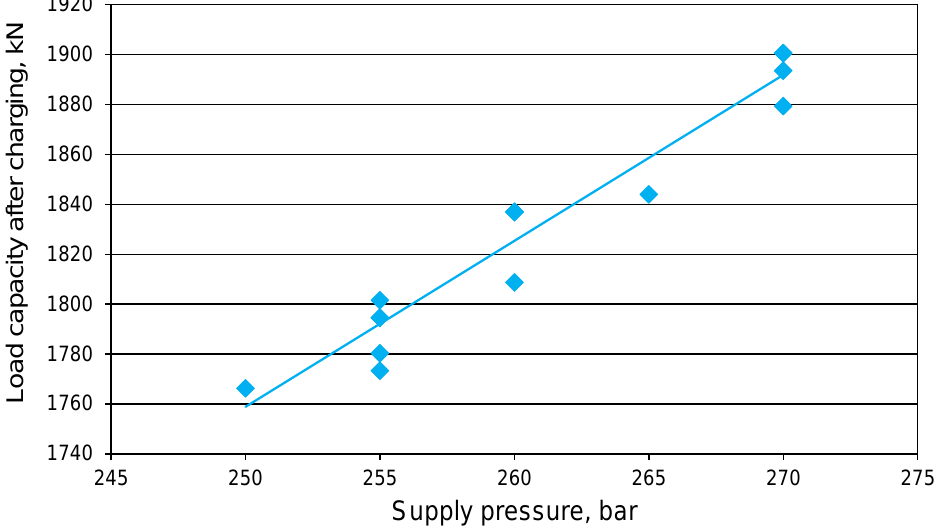
Figure 13. Analysis of the prop’s actual load capacity after charging depending on the pressure in the main power line.